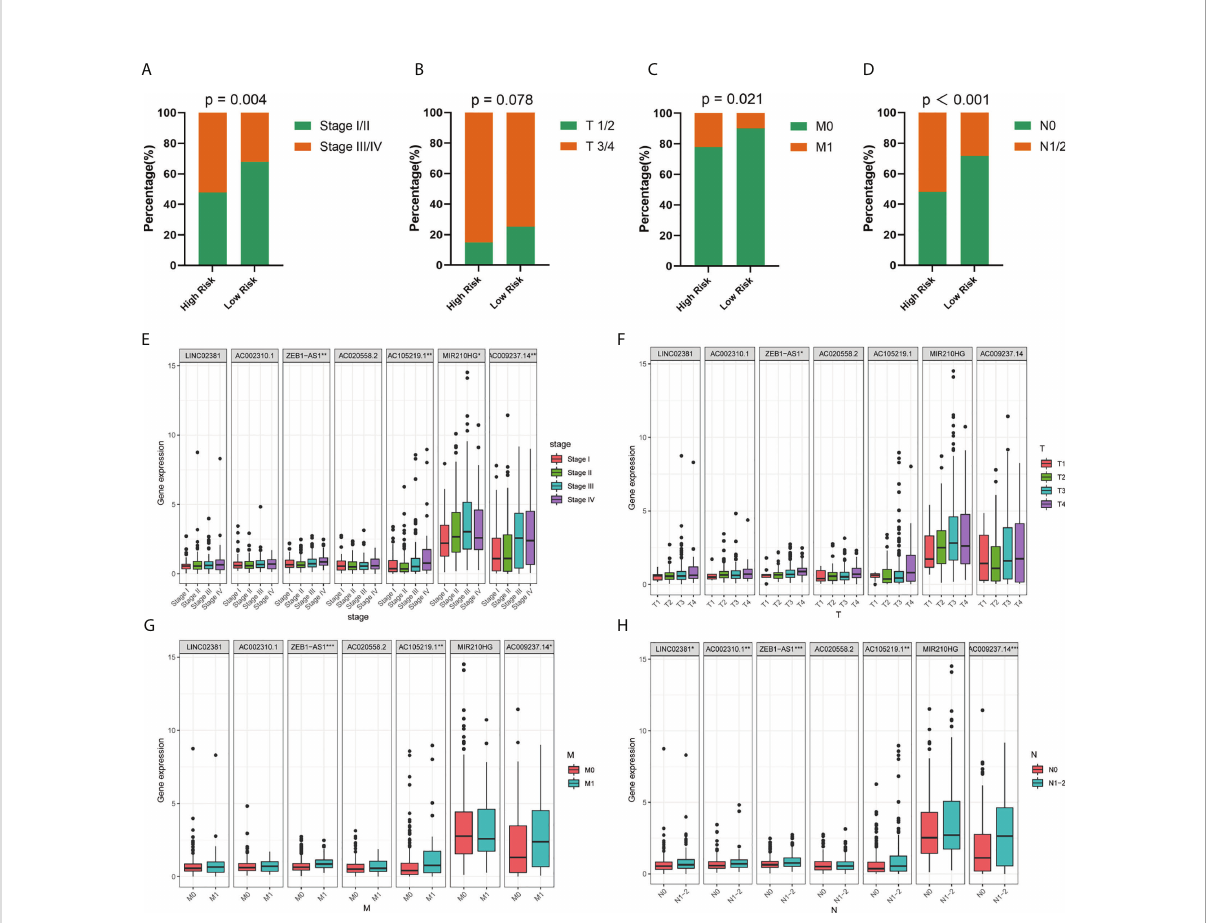
FIGURE 4 Correlation between risk model and clinicopathological factors. (A – D) Distribution of stage I/II and III/IV, T1/2 and T3/4, M0 and M1, and N0 and N1/2 tumors between high- and low-risk group. (E – H) Expression levels of seven prognostic GT-related lncRNAs in T, M, N, and S stage groups. *p < 0.05, **p < 0.01, and ***p <